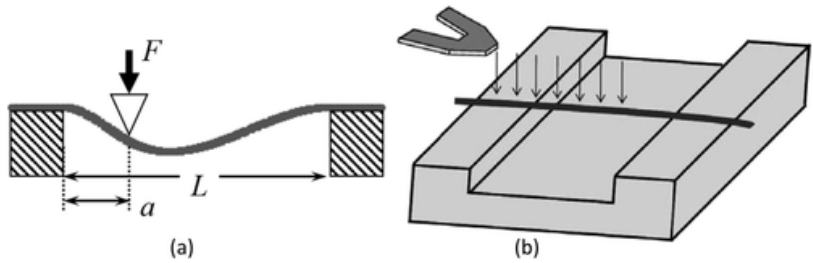
Figure 19. ( a ) A model for the fiber clamped to supports that are apart by distance L under deformation exerted by vertical force F at a distance “ a ” from one end of fiber. ( b ) Schematic of three-point bending test for single electrospun nanofiber. Reproduced from: ( a ) [140] with permission © 2005, American Chemical Society; ( b ) [141] with permission of Elsevier.